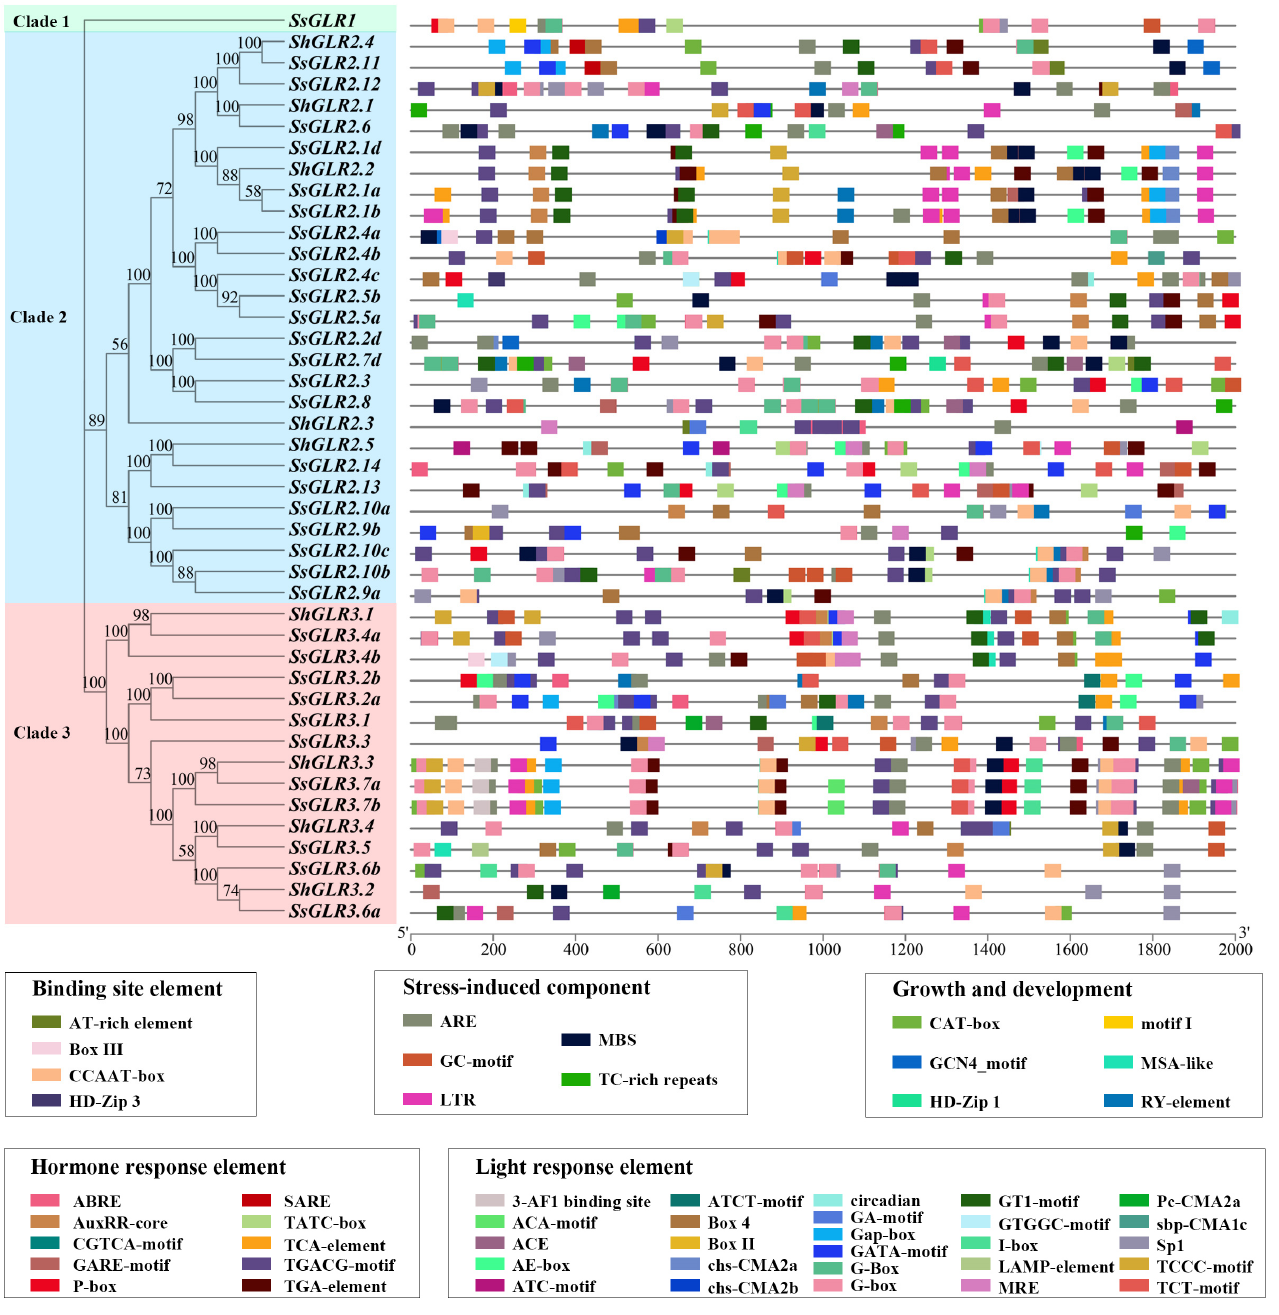
Figure 4. The promoter cis -acting regulatory elements in the promoters of ShGLRs and SsGLRs . Rectangular color blocks with different colors represented different cis -acting regulatory elements, which may overlap each other. The number on the branch of phylogenetic tree represented the bootstrap value.